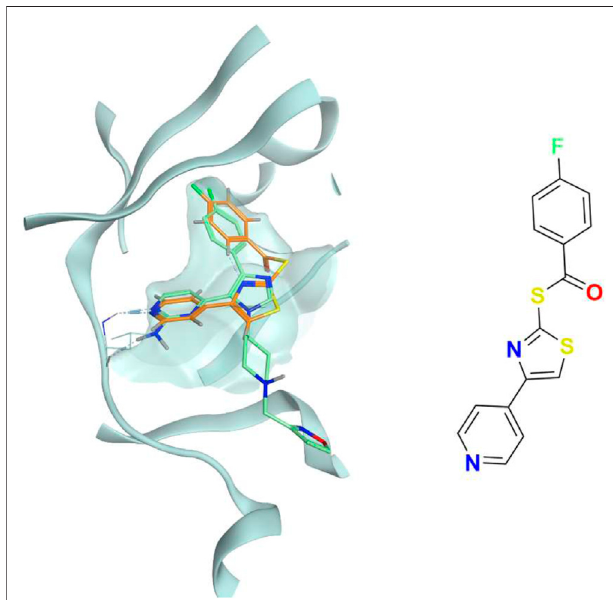
FIGURE 16 | The superposition between the docking-predicted binding mode of a high-scoring compound (MMS3) from the benchmark de novo run performed with the IFP CS scoring protocol and the reference crystal binding pose ofcompound PFOfromthestructure deposited intheProteinData Bank with accession code 4TN6. On the left part of the image, the protein kinase CK1 δ ATP binding site is reported in teal ribbon, the pose of the compound MMS3 is shown as orange sticks, while the pose of compound PFO is shown in green sticks. On the right part of the image, the chemical structure of the compound MMS3 is